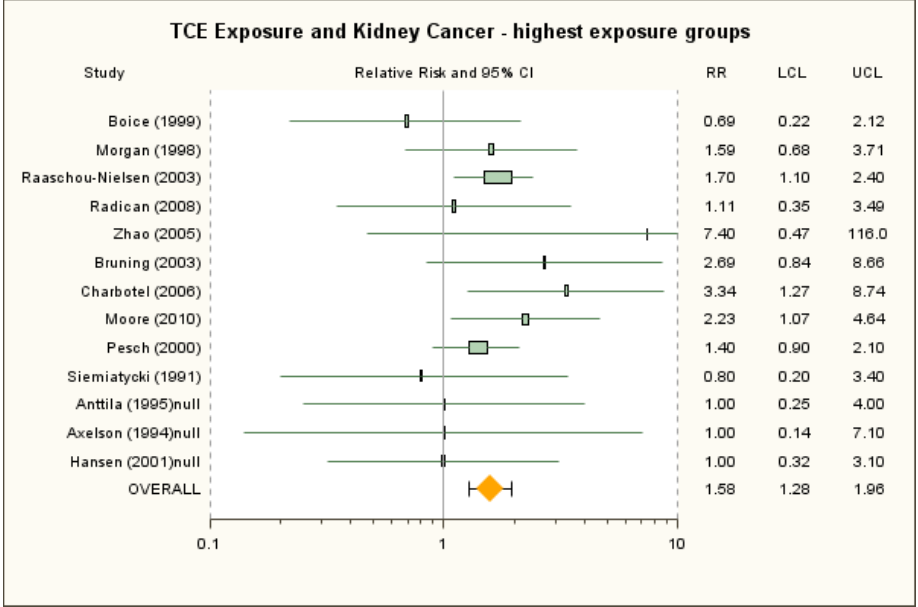
Figure 2. Forest plot of highest TCE exposure group and kidney cancer from random-effects meta-analysis. Individual study results are plotted with 95% confidence intervals. A risk estimate of 1.0 is assigned for highest exposure in Anttila et al . [38], Axelson et al . [37] and Hansen et al . [39] to account for presumed reporting bias. Symbol sizes reflect relative weights of the 13 cohort and case-control